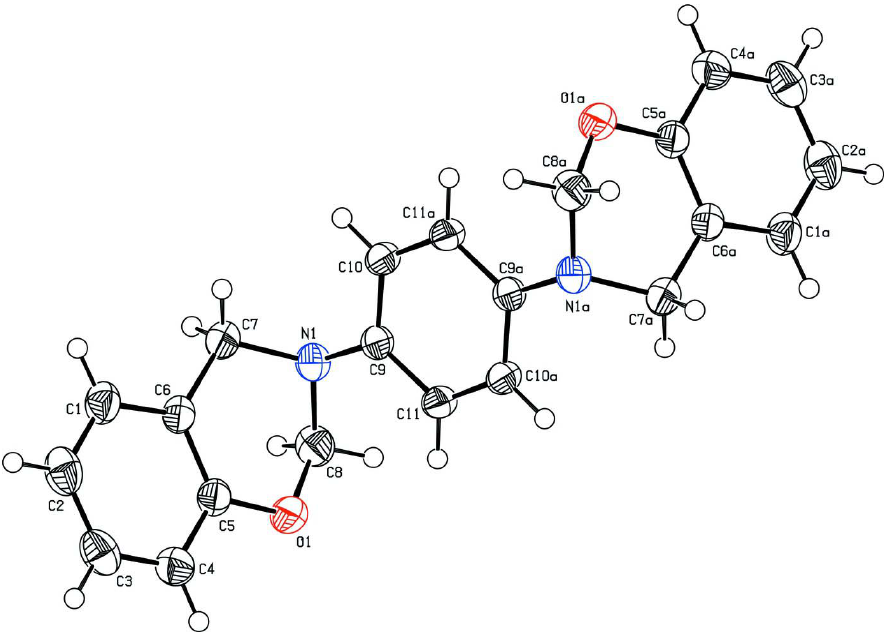
View of the title molecule with the atom labelling scheme. The displacement ellipsoids are drawn at the 30% probability level while the H atoms are shown as small spheres of arbitrary